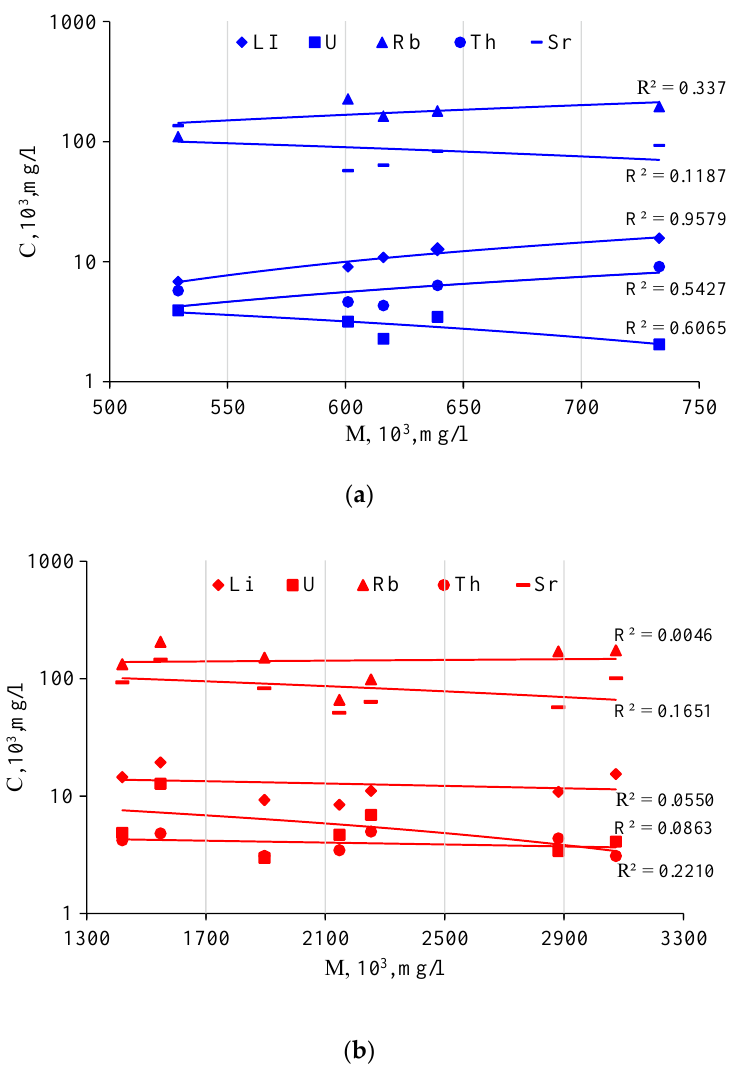
Figure 10. Graphswithrelationshipbetweenmineralization(M)andconcentration(C)ofmicrocomponents (Li, Sr, Rb, Th, and U) in lake water of Burabay rock mass: ( a )—fresh water; and ( b )—salty